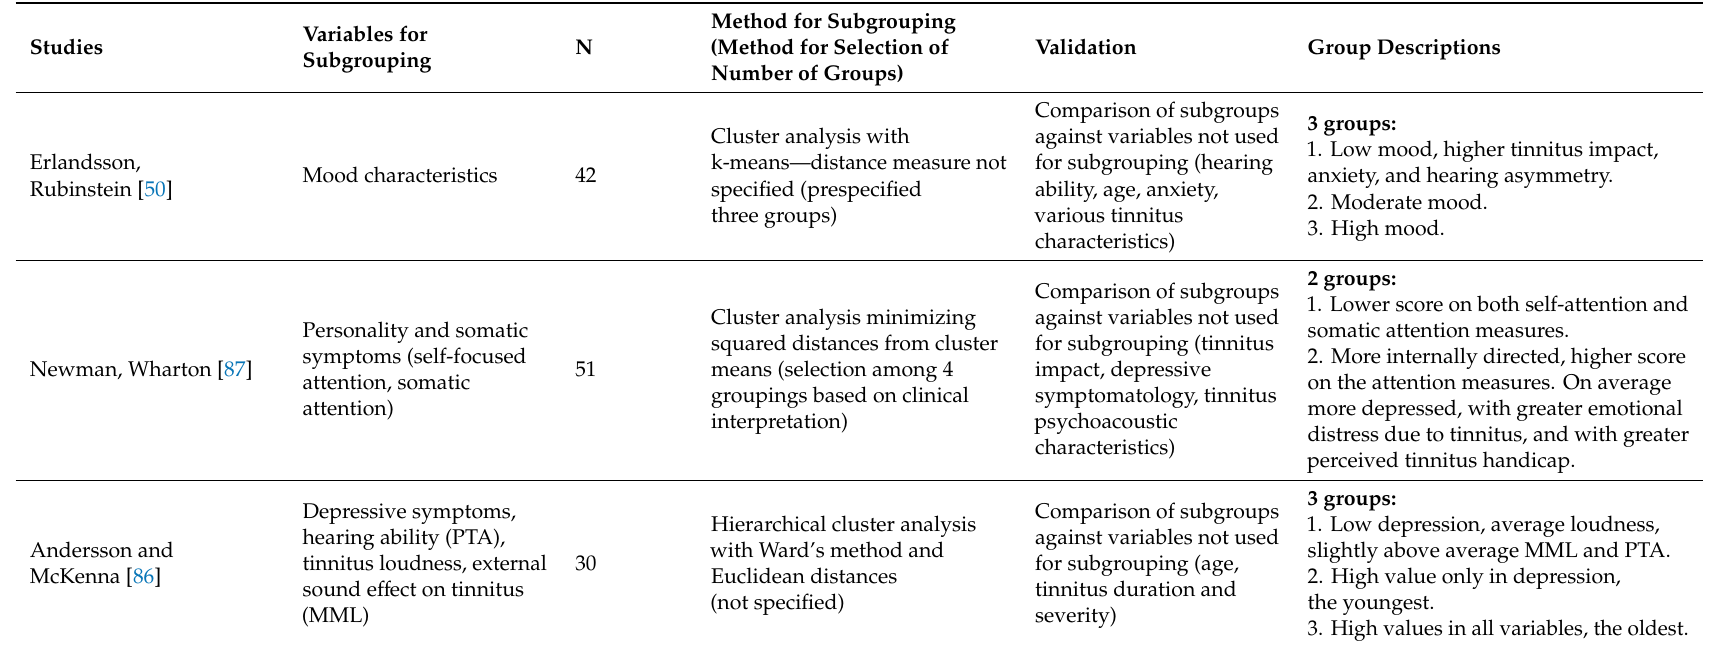
Table 1. Overview of studies reporting data-driven analysis for tinnitus